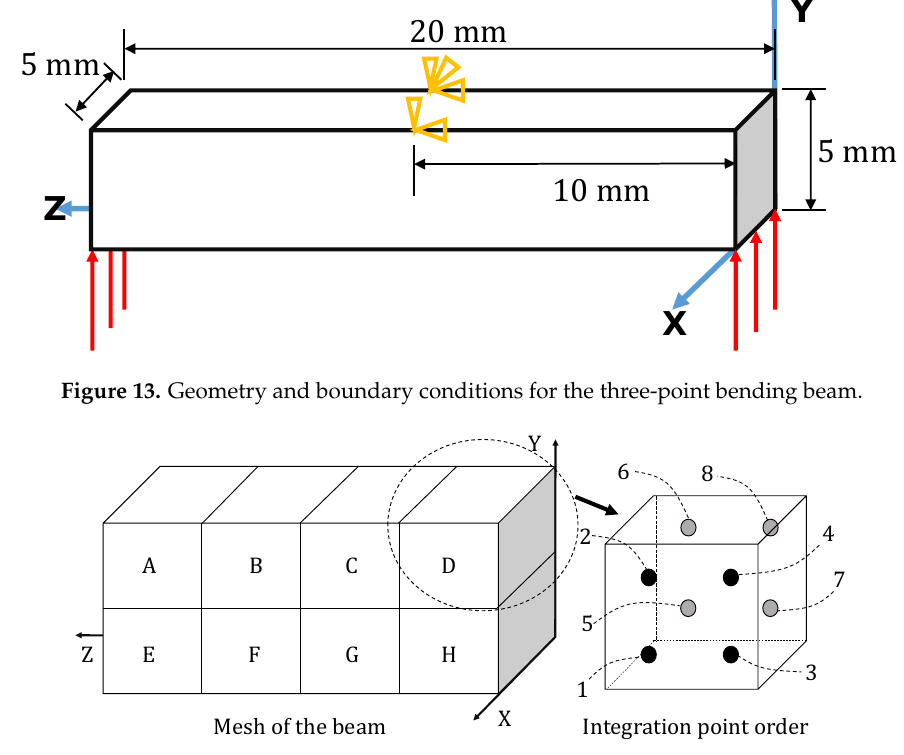
Figure 14. The meshes for the left half beam and the integration points in each C3D8I